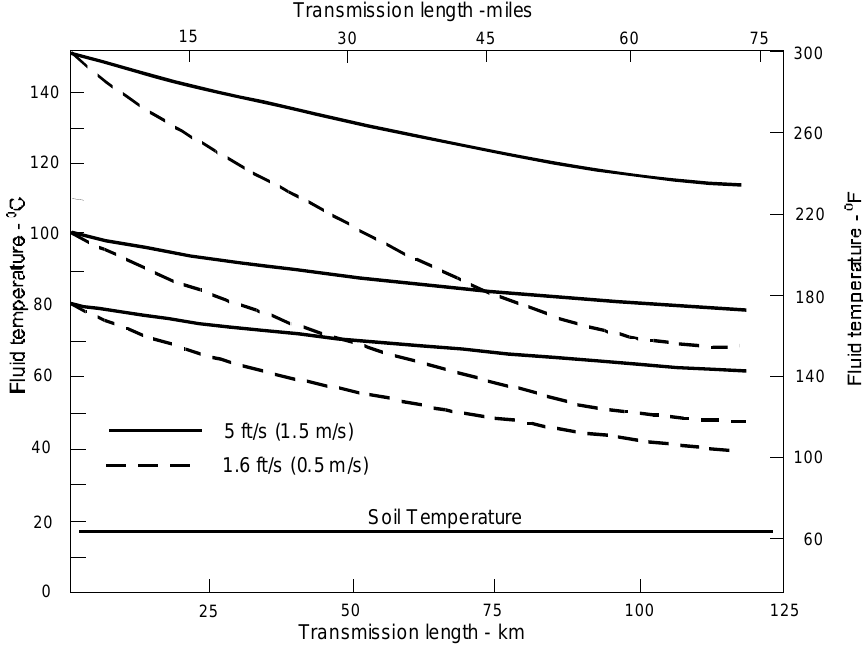
Figure 9. Temperature drop in hot water transmission lines